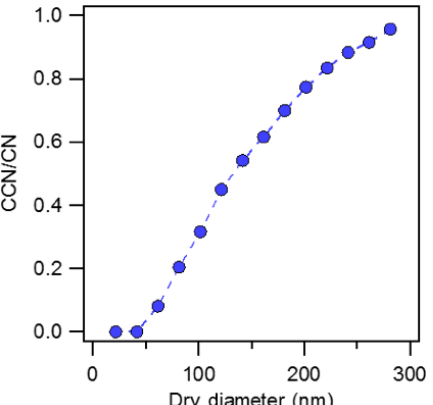
Figure 7. Combustion aerosol activation curve (SS 2.2%, d p, 50 = 133nm, κ = 0 . 001).